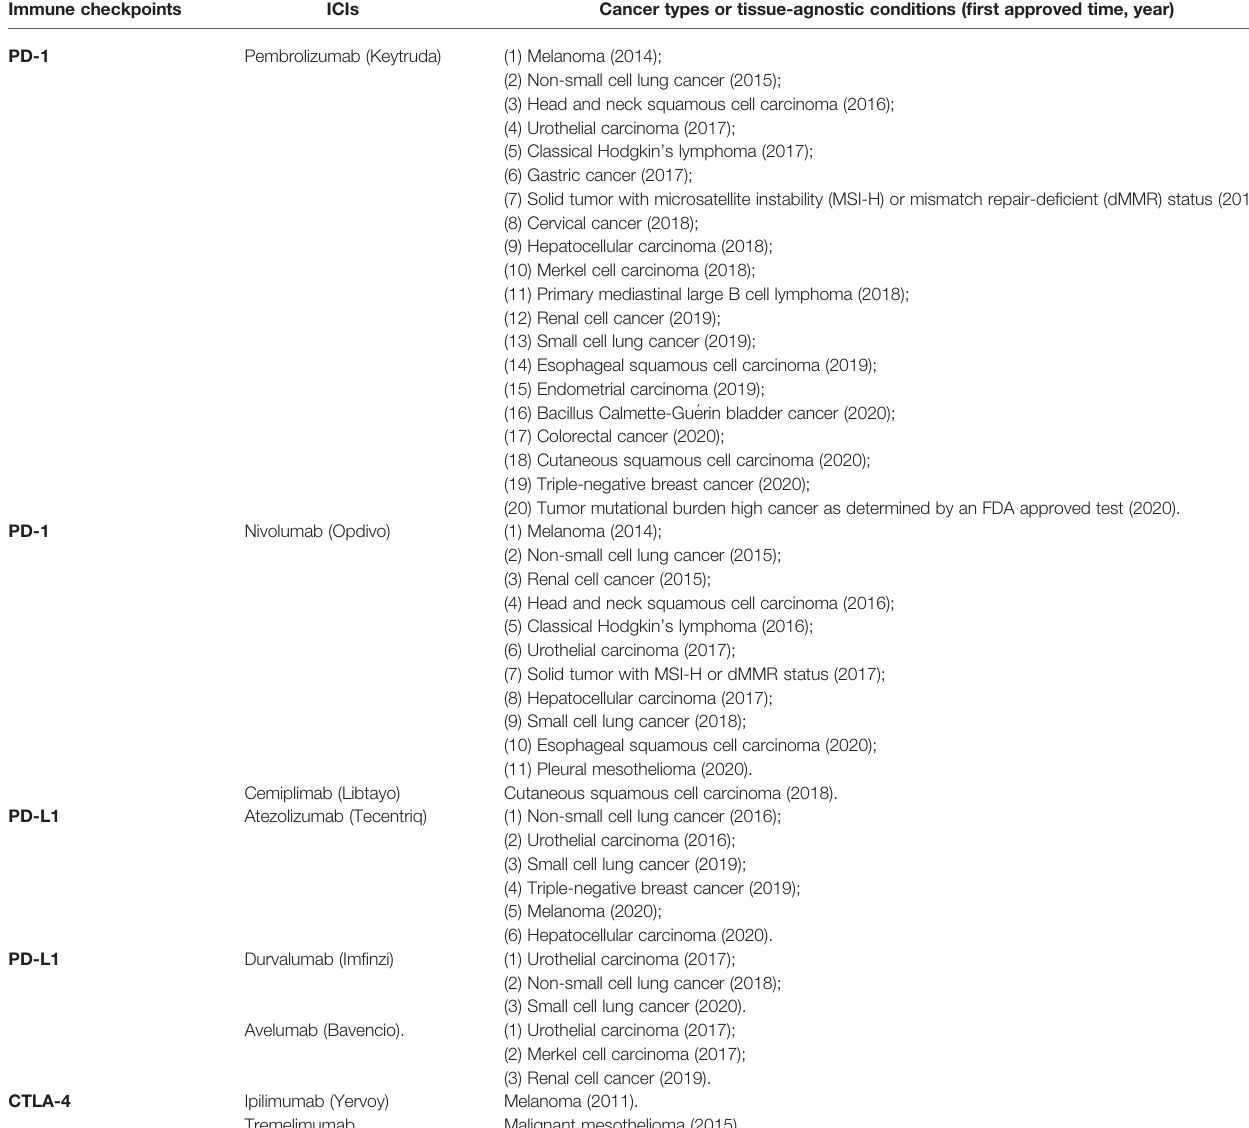
TABLE 1 | Update and summary of ICIs approved by FDA for cancer treatments. Immune